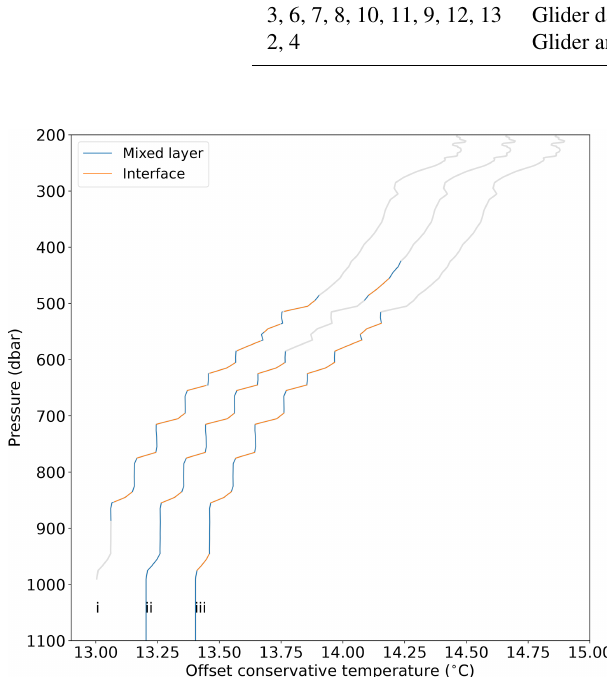
Figure 5. The same Argo profile shown in Fig. 1 from the Mediter- ranean classified three times. Three lines on this plot are (i) VDB’s result, (ii) our classifier on default settings and (iii) our classifier with a 10% decrease in step height ratio and a 4% decrease in max- imum permitted density gradient. The first profile is at the unaltered temperature; subsequent profiles are offset by 0.2 ◦ C for